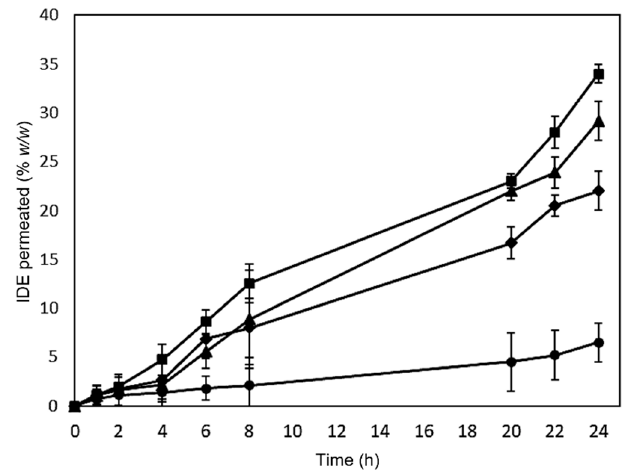
Figure 7. Permeation profiles across the excised bovine nasal mucosa of free IDE (circles), IDE/HP- β -CD inclusion complex (squares), non-overloaded CS NPs (diamonds), and the overloaded CS NPs-PC (triangles). The results are presented as the means of six different experiments ± standard deviation.